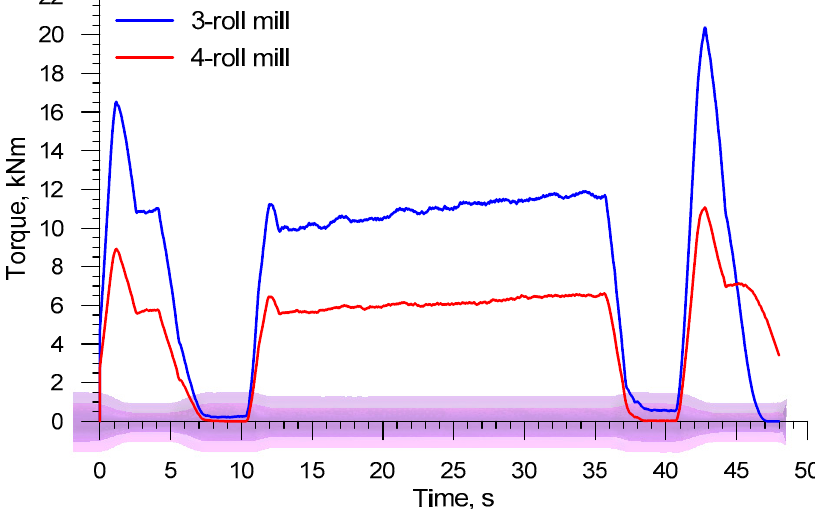
Figure 17. Torque on the roll in skew rolling hollow axles in 3- and 4-roll mills.